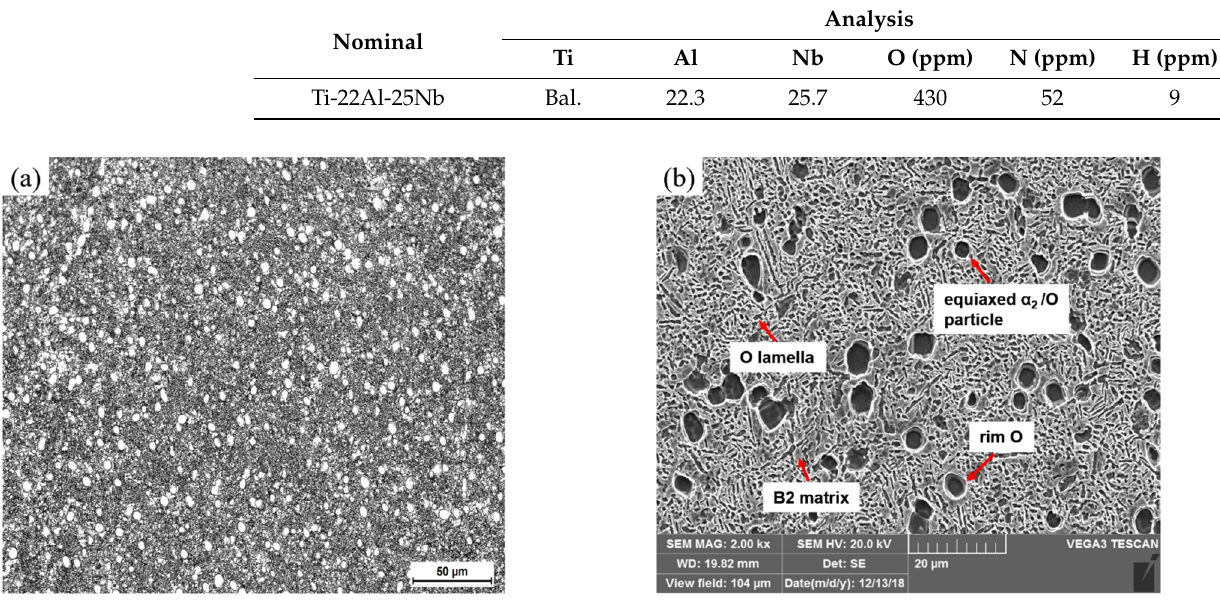
Figure 1. Microstructure of the alloy after forging: ( a ) OM; ( b )